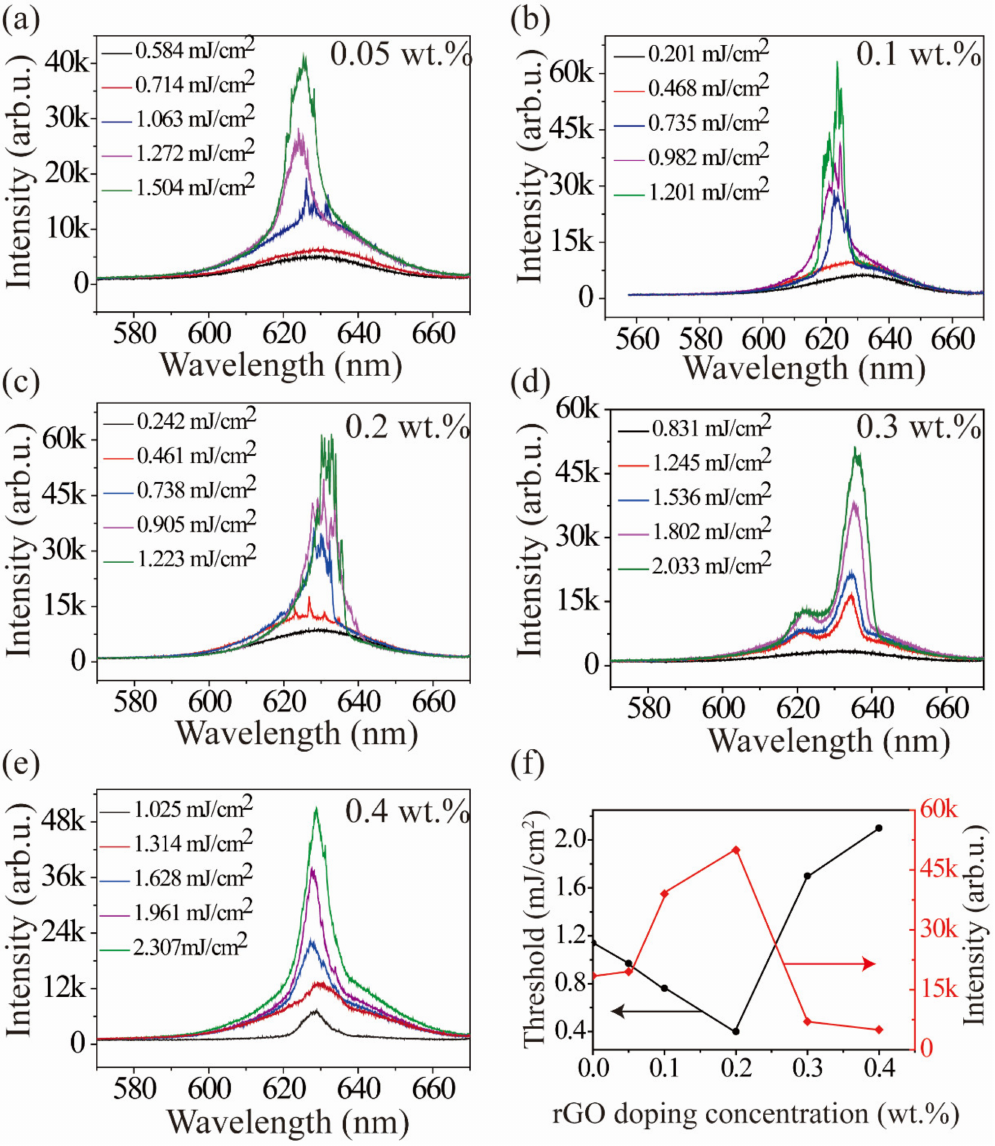
Figure 6. ( a – e ) Random laser emission characteristics of reduced graphene oxide at different concen- trations; ( f ) the peak output intensity (red line) and laser threshold (black line) of colloidal quantum dots as a function of reduced graphene oxide